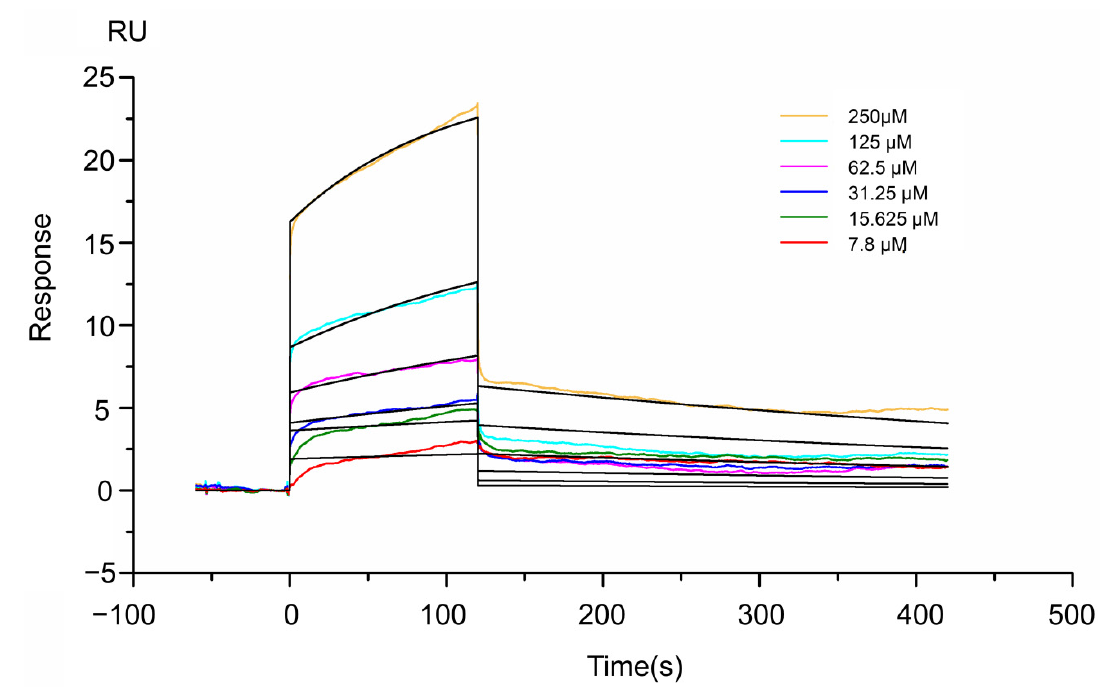
Figure 8. Binding activity of rTbprx-1 with tetrodotoxin (TTX). Steady—state fitting to obtain the KD value of rTbprx-1.